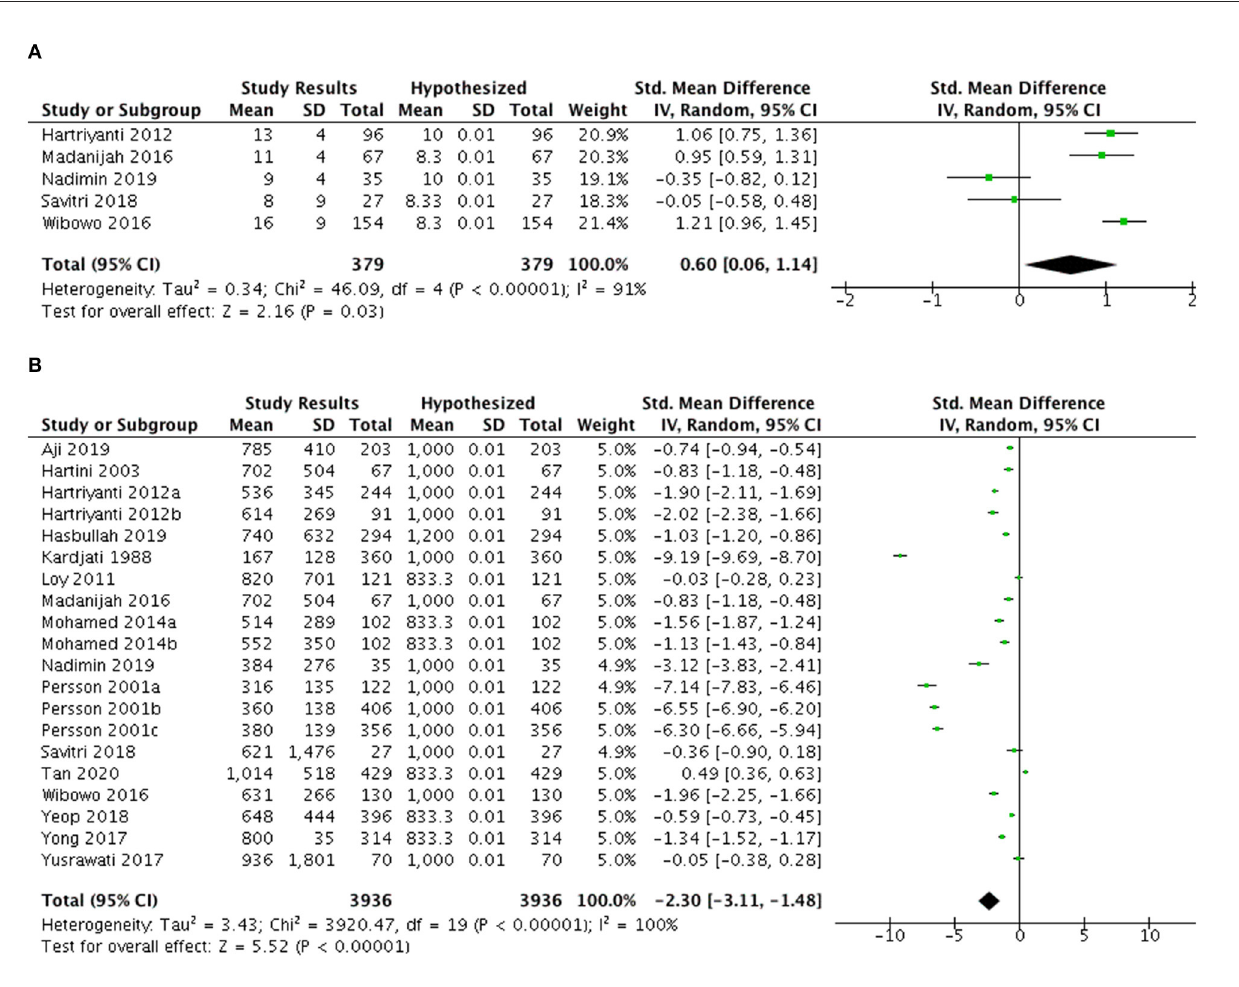
FIGURE5 Meta-analysis of studies on (A) zinc intake and (B) calcium intake among pregnant women in Indonesia and